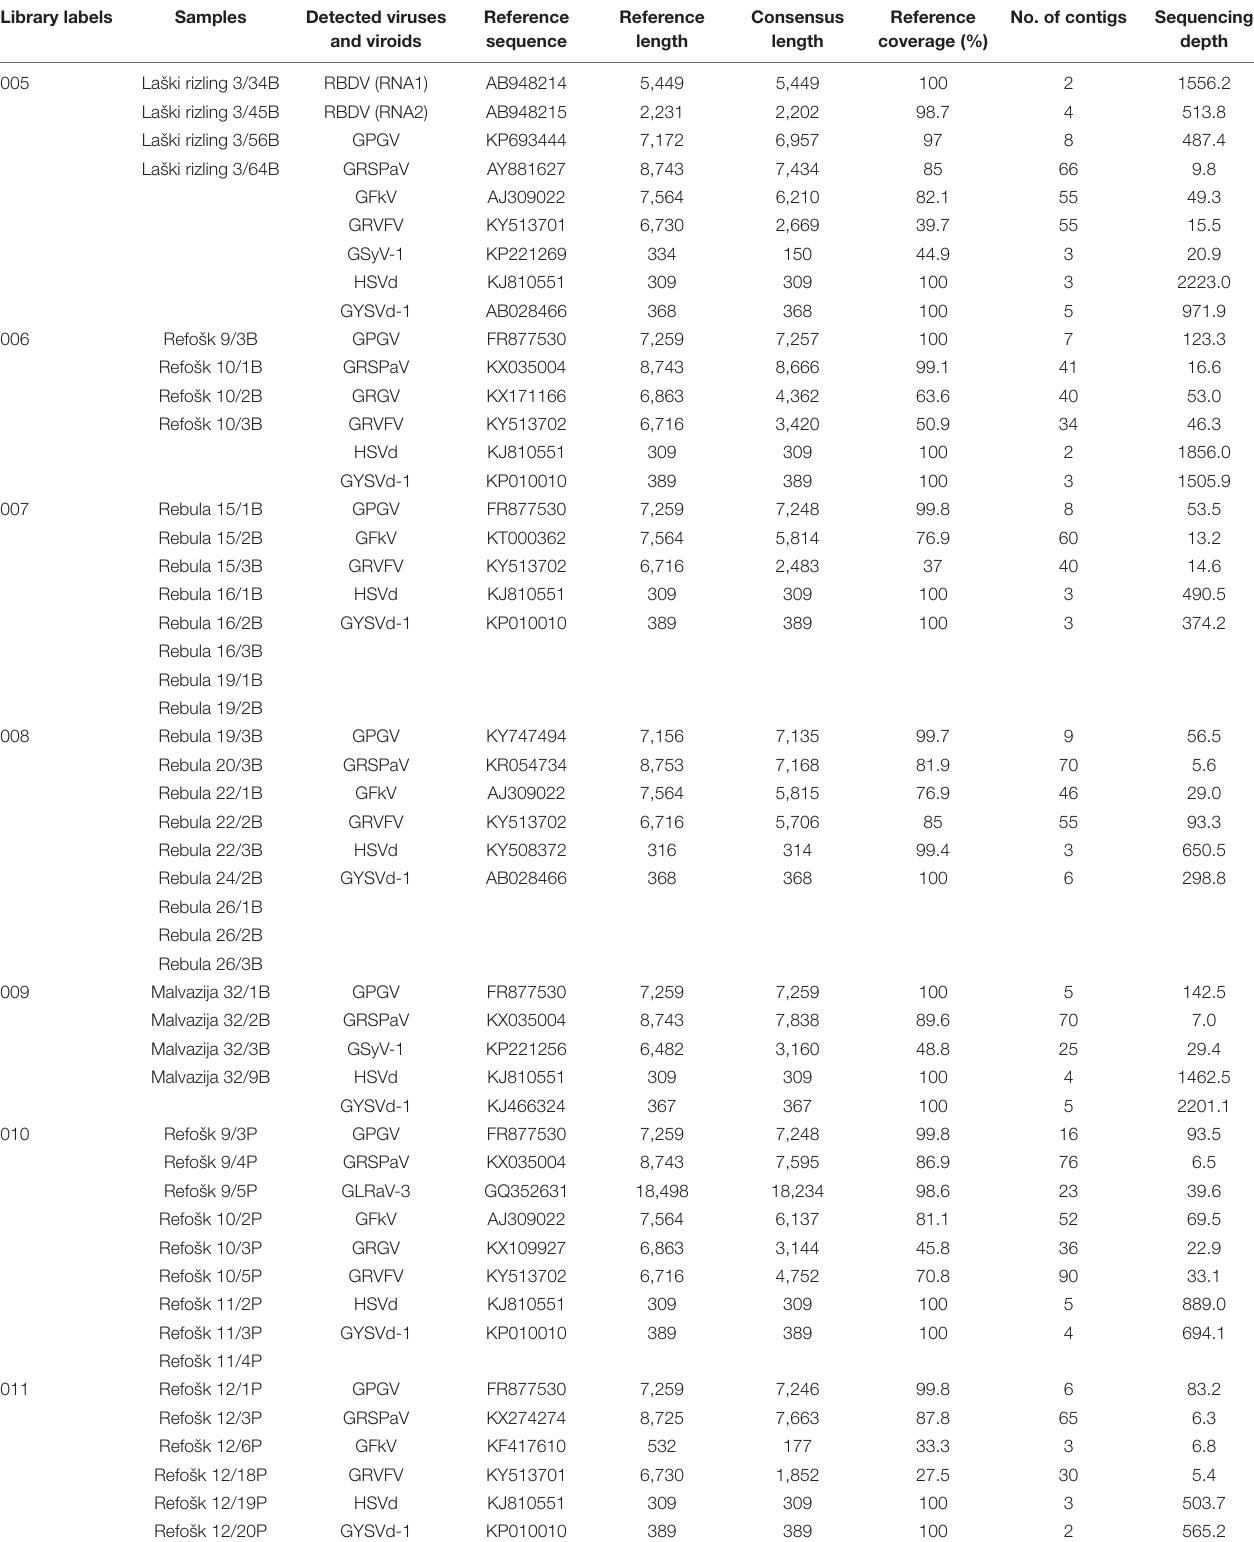
TABLE 1 | Viruses and viroids detected in 12 libraries using the VirusDetect approach. Library